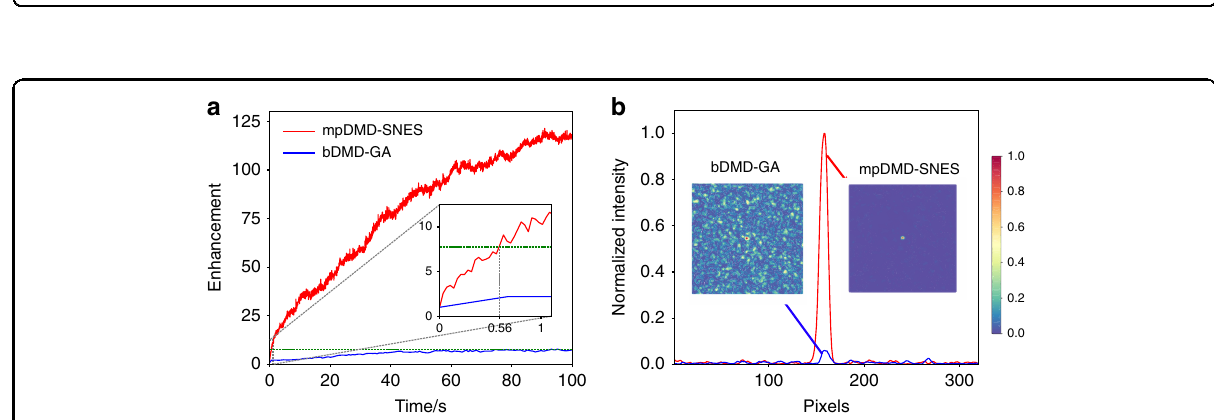
Fig. 5 Experimental comparison between mpDMD-SNES and bDMD-GA WS methods. a Optimization curves of mpDMD-SNES and bDMD-GA WS methods. The inset zooms in the interval between 0 and 1 s. b Light intensity along the central horizontal line in the images of the focus, optimized by mpDMD-SNES (red curve and right image) and bDMD-GA (blue curve and left image) WS methods, respectively. Scale bar, 500